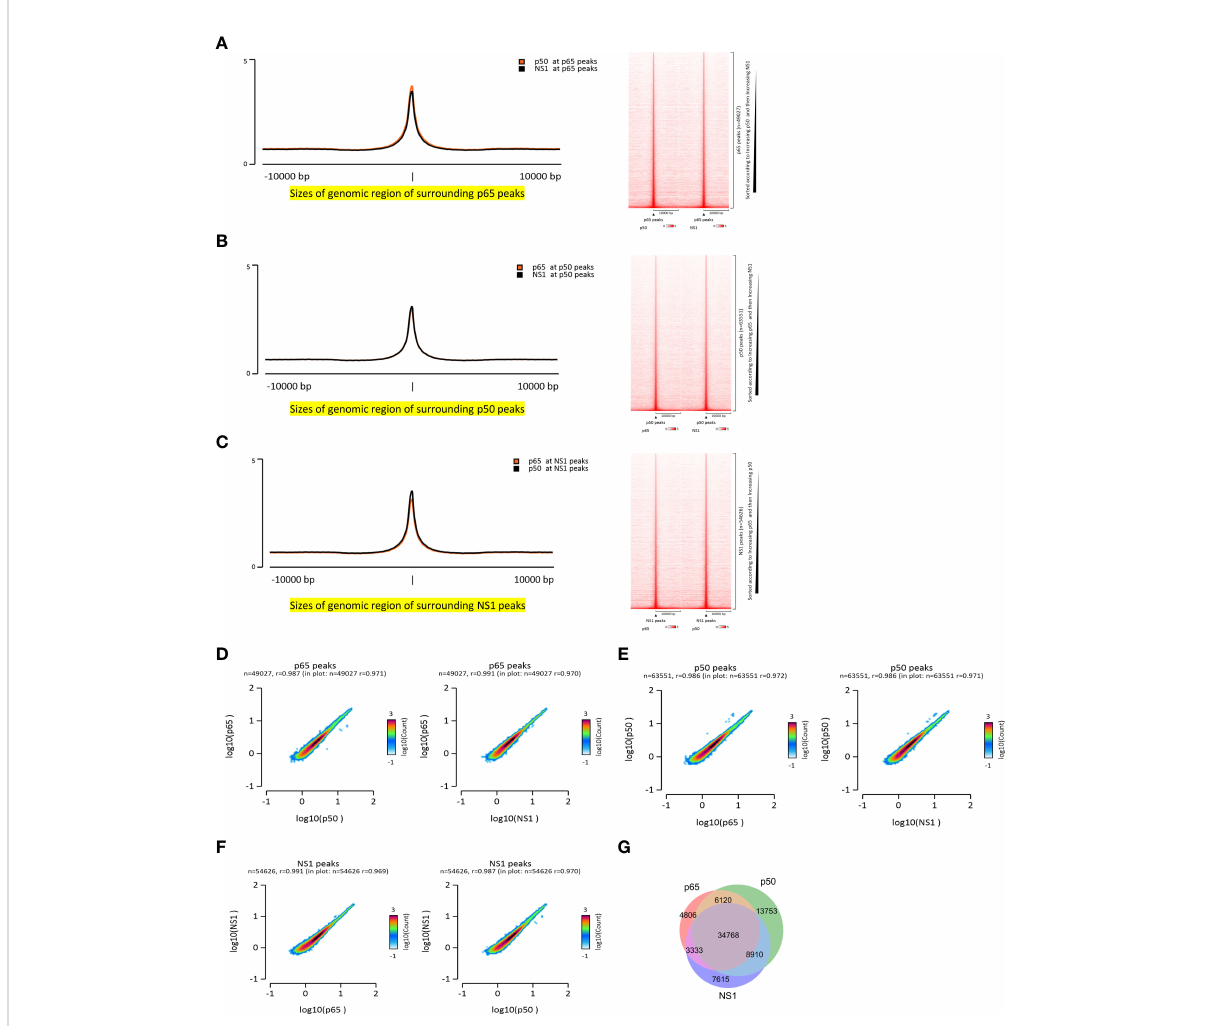
FIGURE 1 Co-localization of NF- k B and NS1 during IAV infection. (A – C) Enrichment signals of NF- k B and NS1 are depicted in the peak plot and heatmap aligned to NF- k B and NS1, respectively. (D – F) Pair correlation coef fi cient plot of the NF- k B- and NS1-enriched signals based on the NF- k B and NS1 peaks, respectively. (G) Venn plot of the NF- k B and NS1 intersection